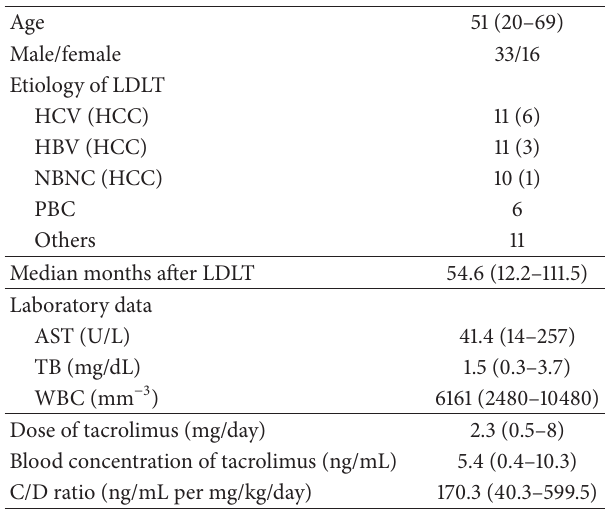
Table 1: Characteristics of the 49